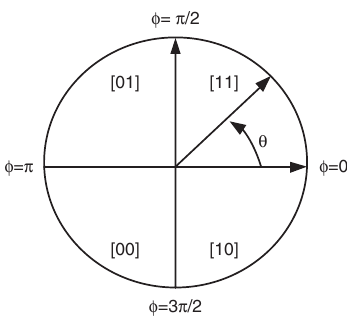
Figure 17. Quadrant Demodulation